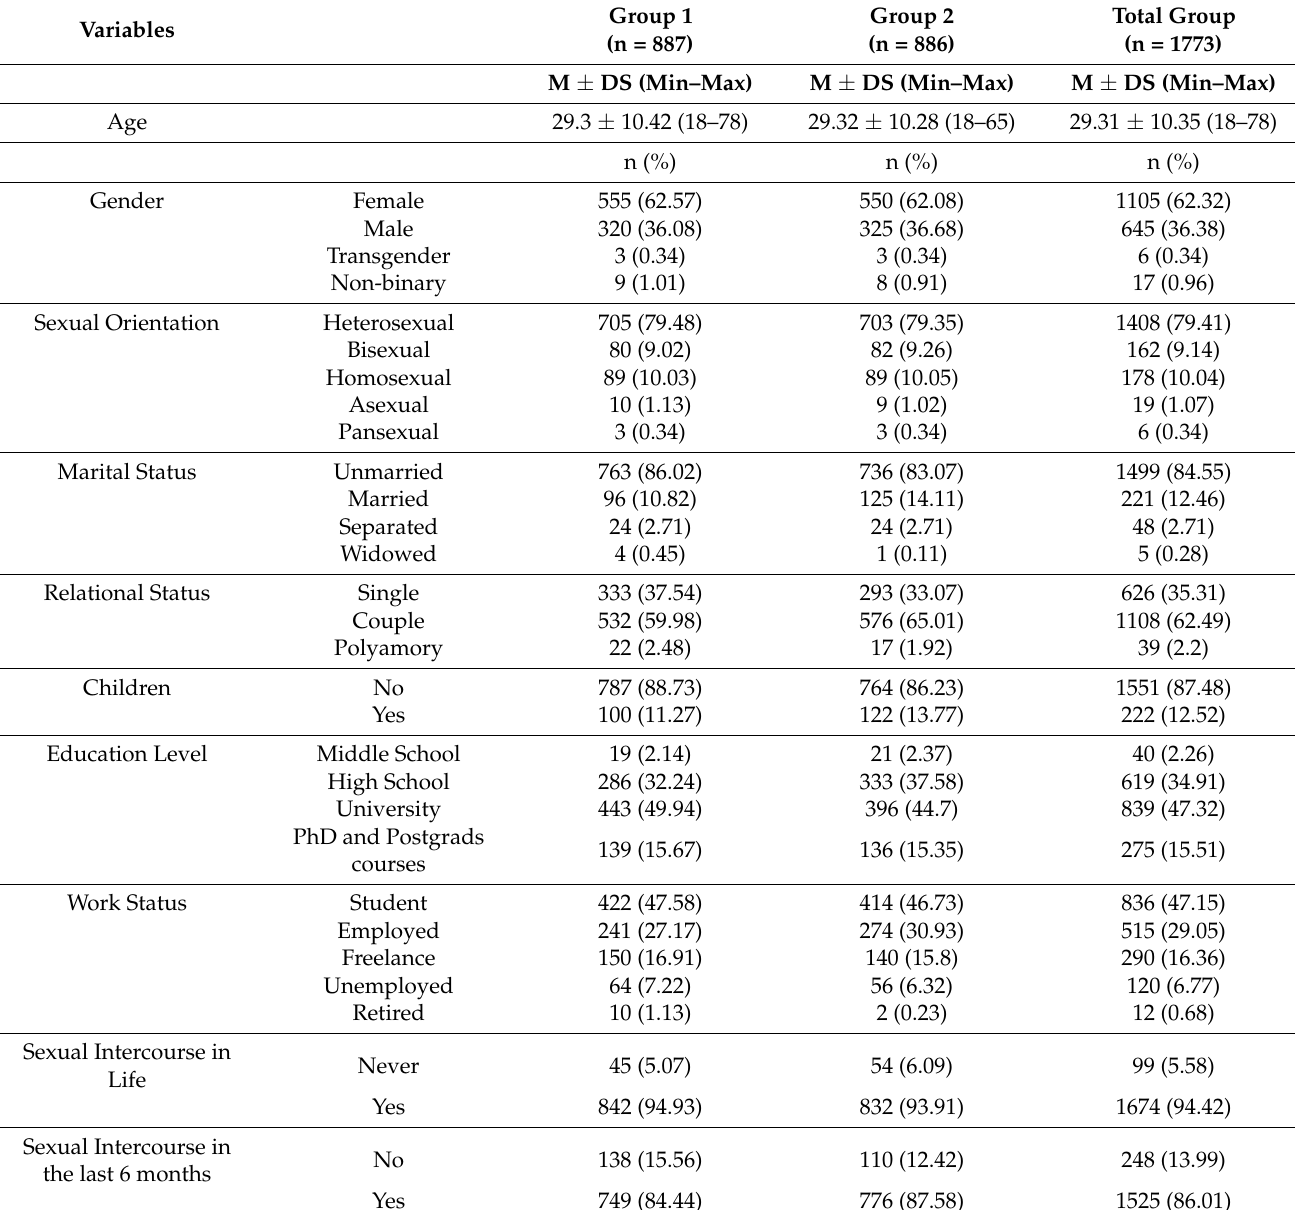
Table 1. Sociodemographic variables